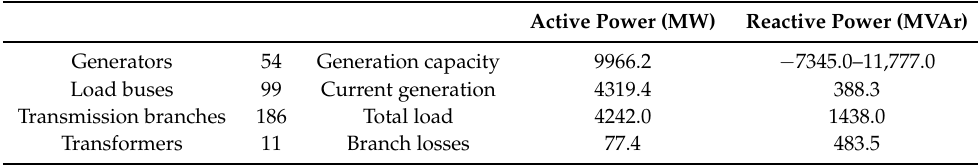
Table 1. System summary for the IEEE 118-bus power